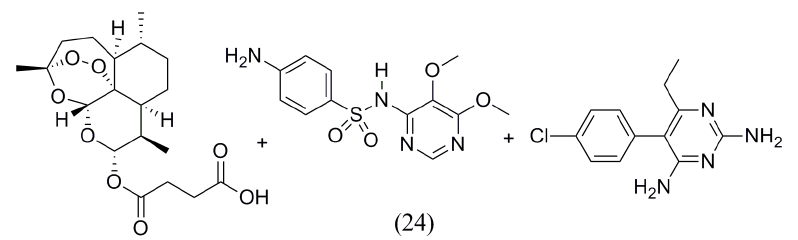
Figure 9 - Structure of drugs used in combination 24